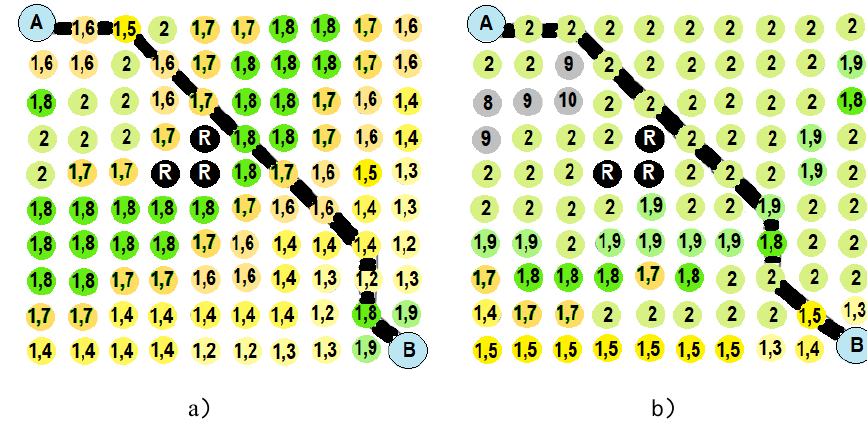
Fig. 5. Optimal routes in the presence of prohibited zones and minor PDOP variations.